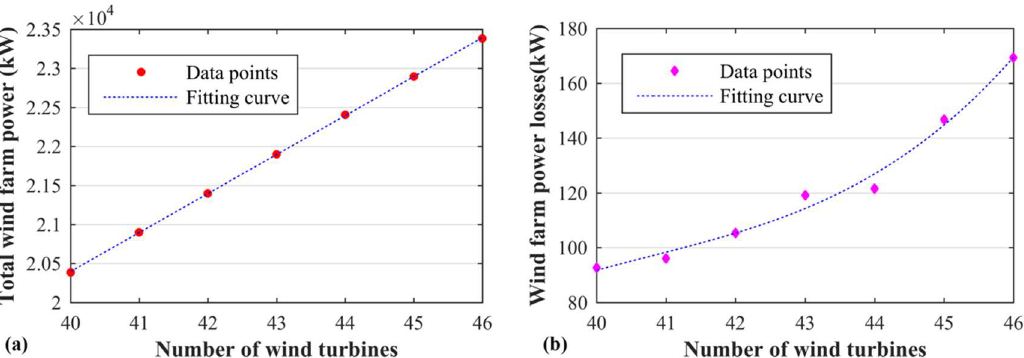
Figure 4. Results of wind farm layout optimization with different number of wind turbines under constant wind speed and constant wind direction: ( a ) wind farm power production and ( b ) wind farm power losses.